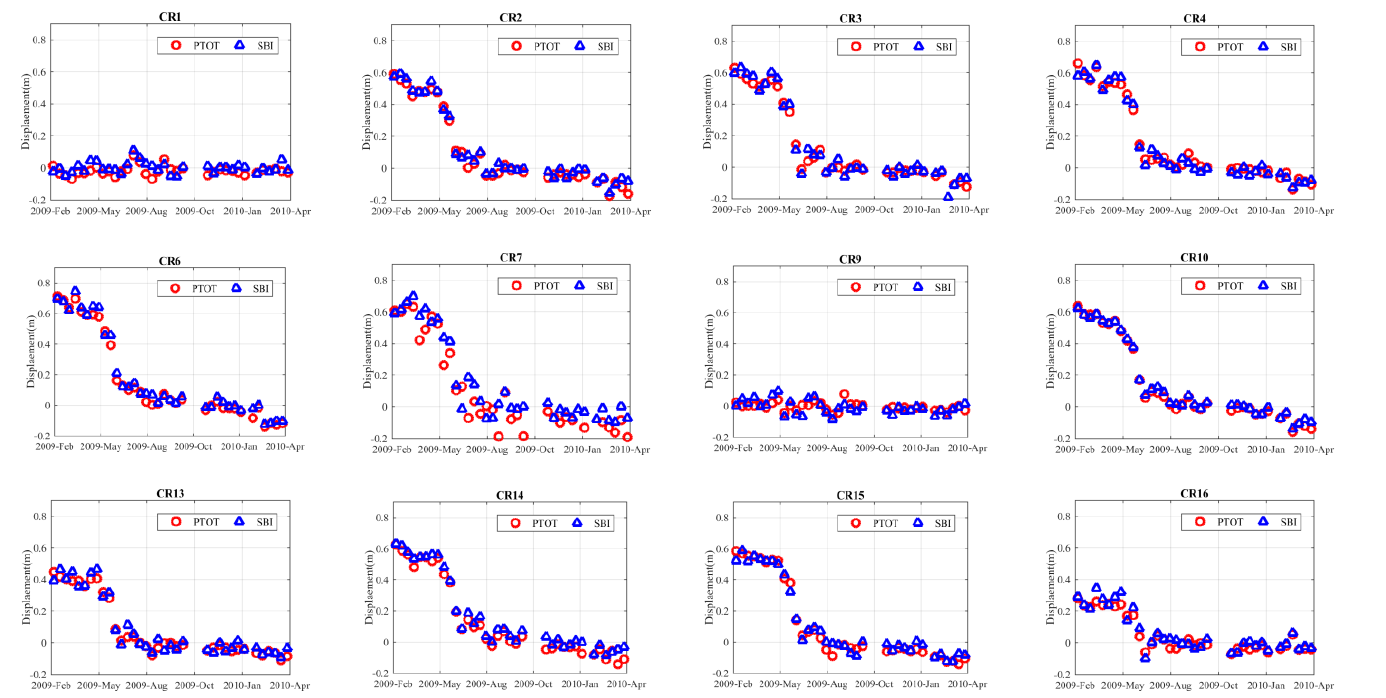
Figure 5. Comparison of time series displacements of CRs at Shuping landslide in azimuth direction obtained by PTOT and SBI method.